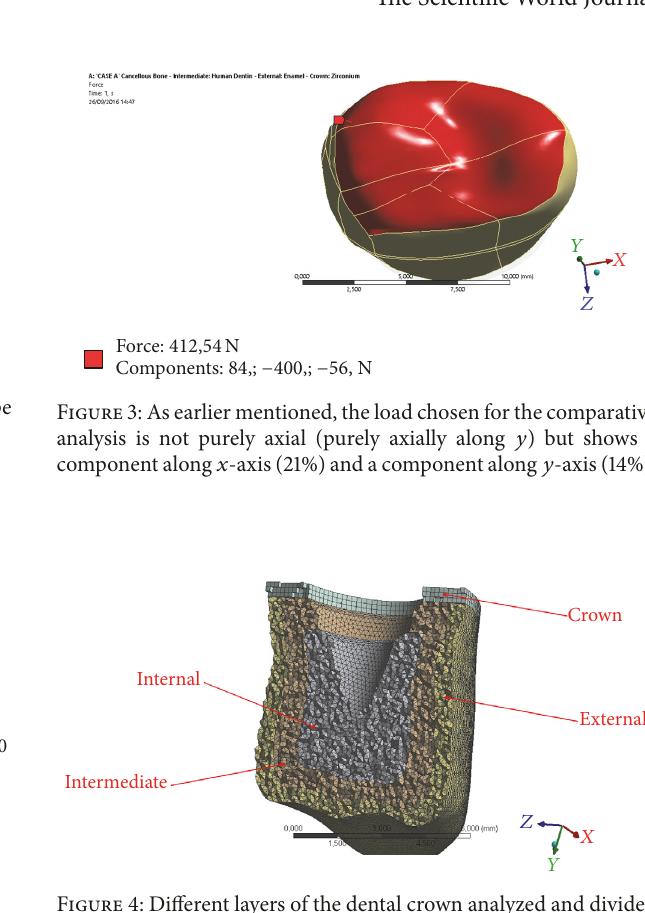
Figure 2: Sensitivity mesh analysis for number of elements.